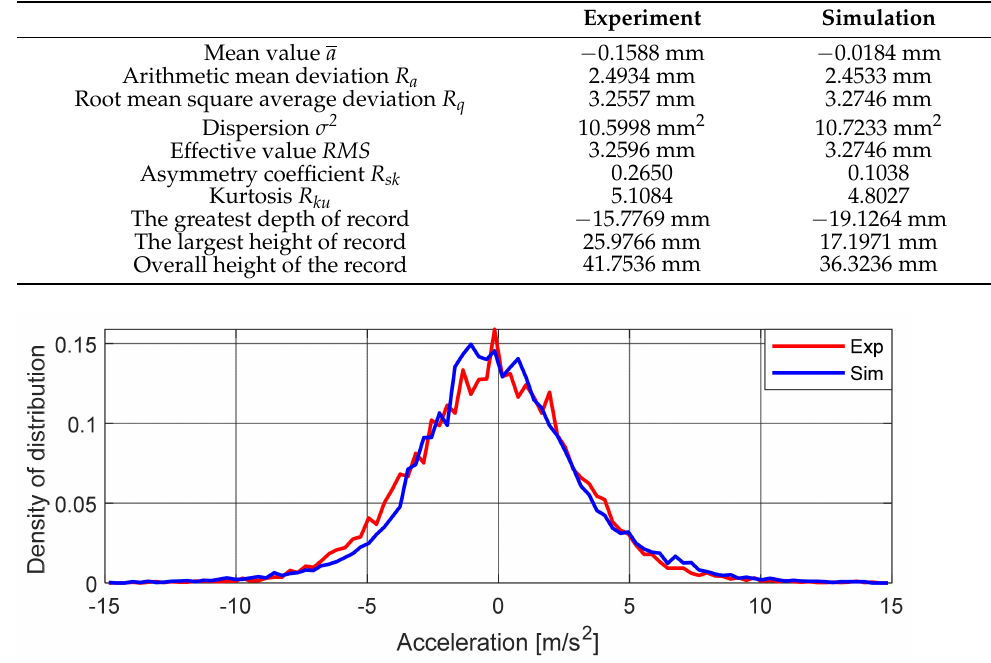
Figure 37. Density of probability distribution, acceleration on vehicle RA.